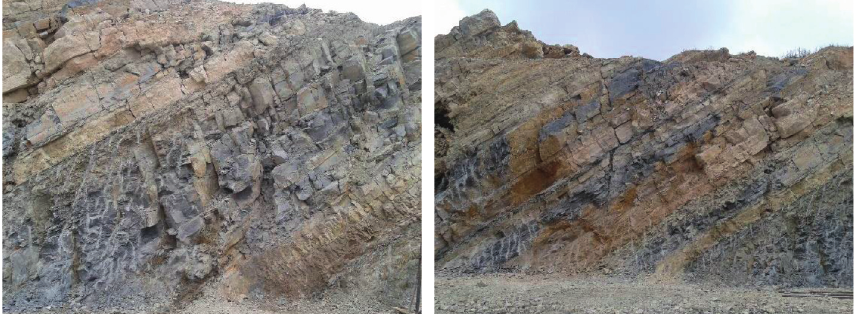
Figure 1: Typical rock mass in engineering. (The picture shows the actual situation of a construction site in Guiyang City, Guizhou Province, China).